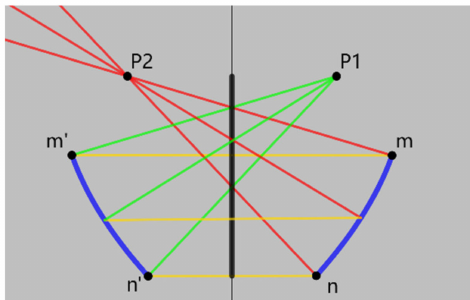
Figure 6. Schematic of the parabolic surface S1 showing the isosceles-triangle pathway for sunlight using different colors. Red, yellow, and green lines represent the solar rays before reflection in the cavity, after the first reflection, and after the second reflection,